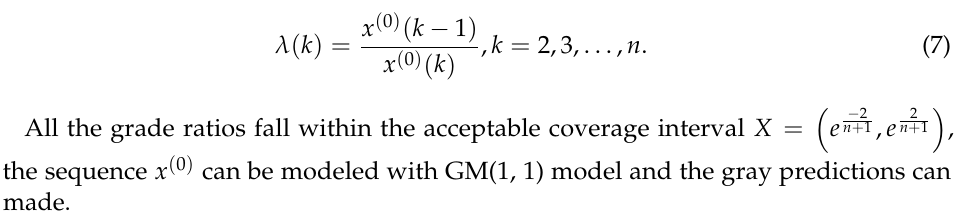
Figure 15. Predication of sector’ digital transformation in China.